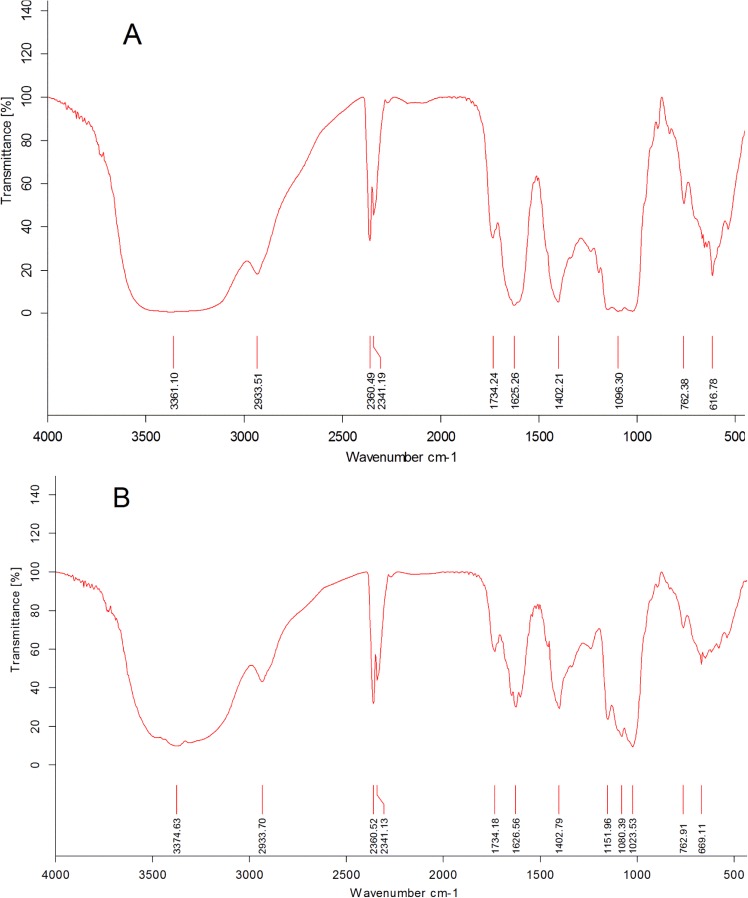
Infrared spectra of SCP (A) and SCP (B).